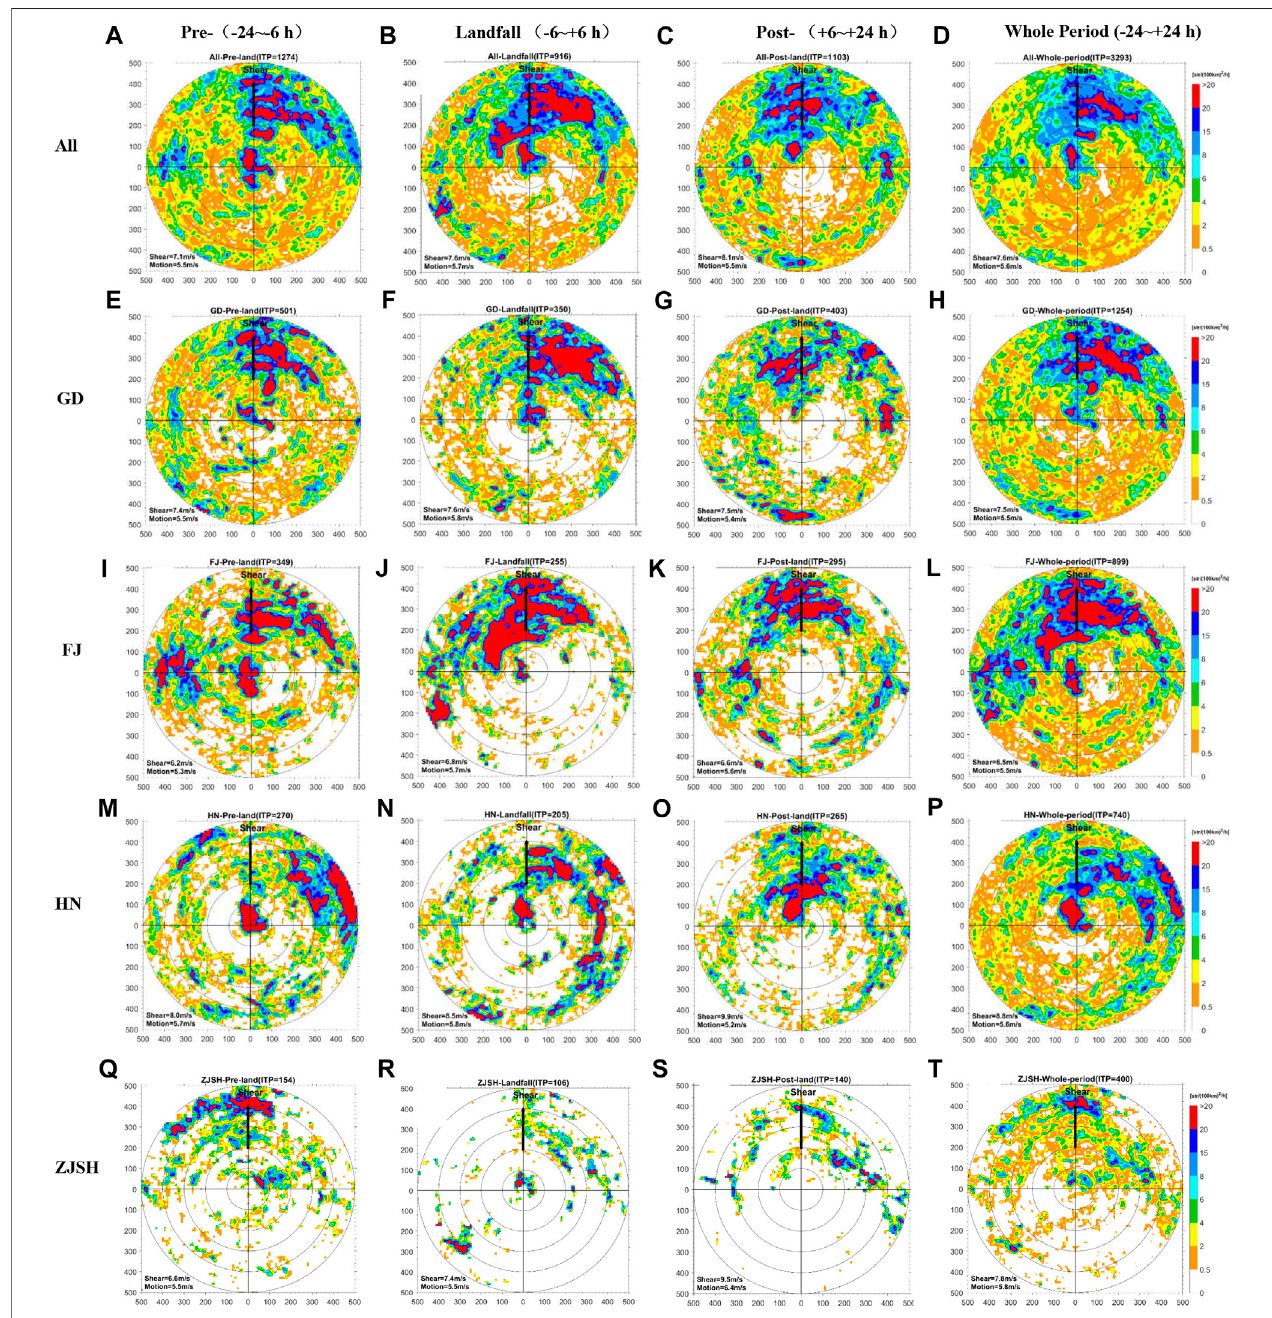
FIGURE 8 | Shear-related lightning density (str (100 km) − 2 h − 1 ) as a function of landing location for pre-landfall (-24~-6 h), landfall (-6~+6 h), post-landfall (+6~+24 h), and the whole period (-24~+24 h). (A – D) all ITPs, (E – H) Guangdong, (I – L) Fujian, (M – P) Hainan, (Q – T) Zhejiang and Shanghai.